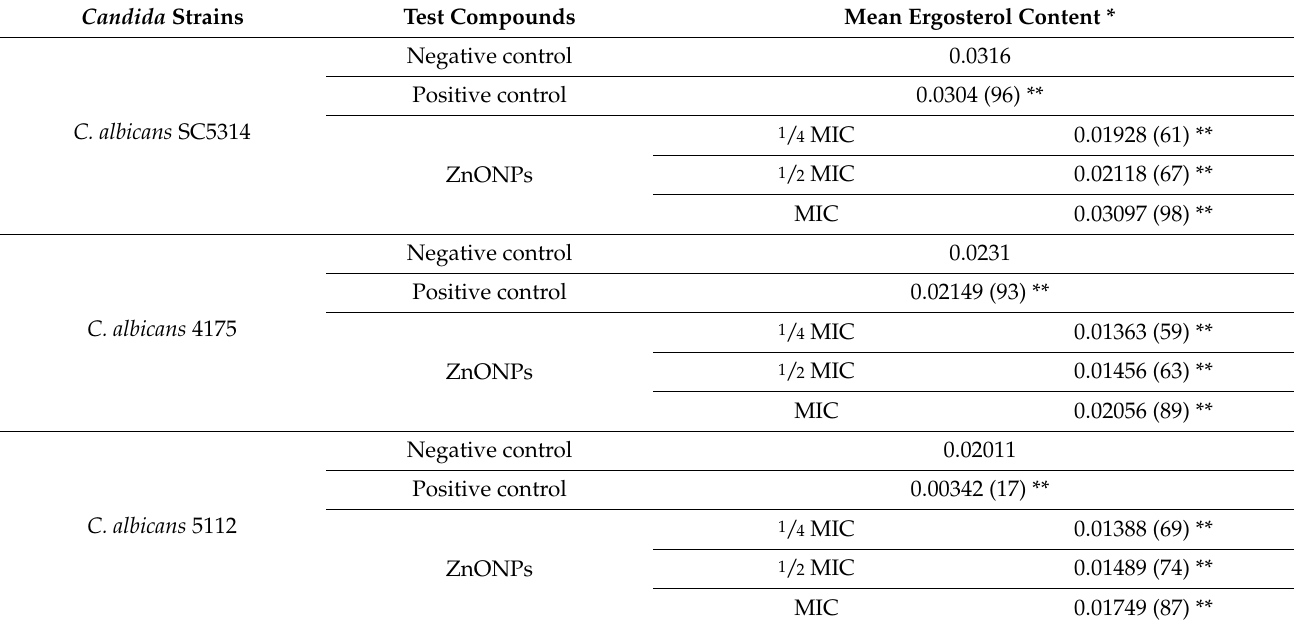
* Expressed as a percentage of the wet weight of the cell ± standard error of the mean (followed in parentheses by the percent reduction in the mean cellular ergosterol content compared with the untreated control). ** Significant reduction compared with controls ( p < 0.05) after Student’s t-